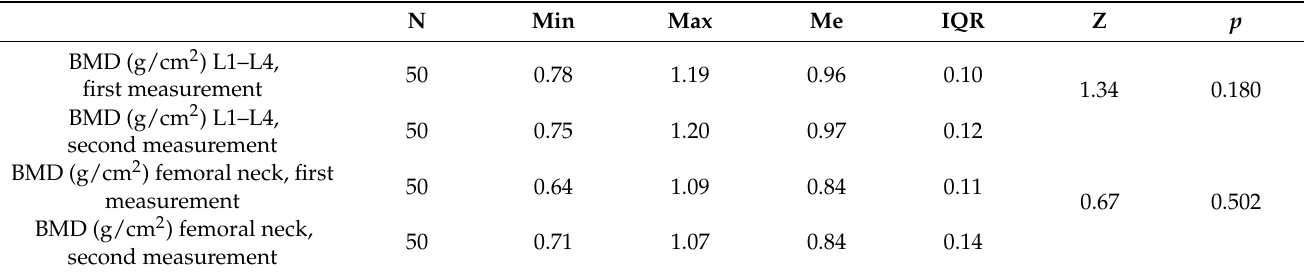
Table 2. Differences between the average values of T-score and BMD after 12-month TNFinhibitor therapy. N Min Max Me IQR